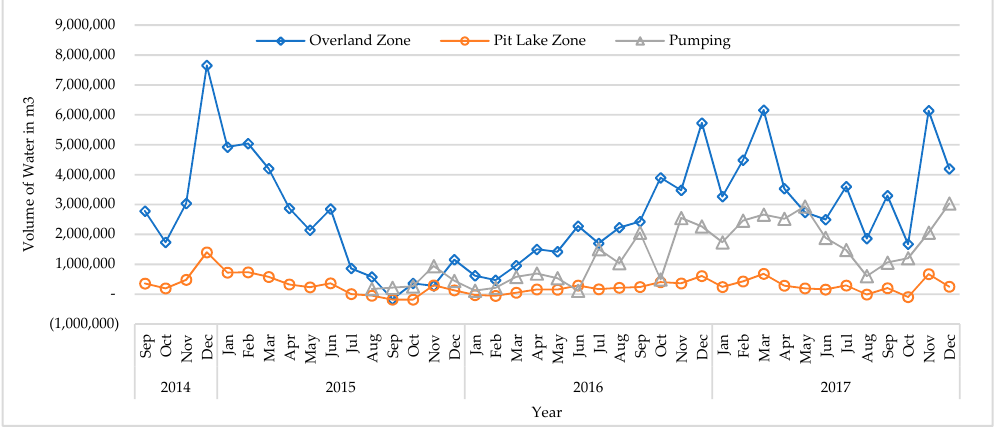
Figure 11. Water Balance.